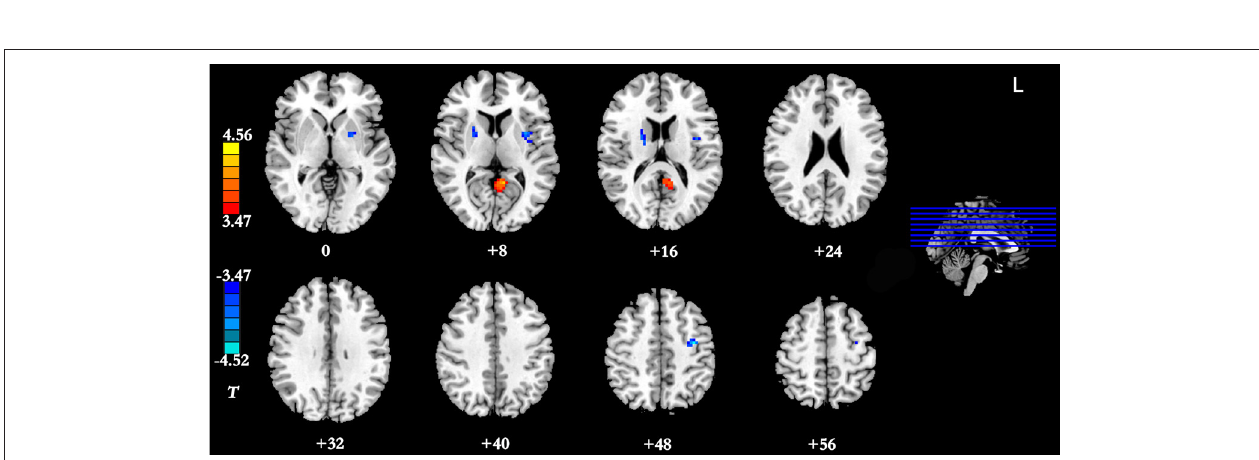
FIGURE 4 | Brain regions showing group differences between the IGD group and the HC group in dynamic FC with the right DLPFC as seed ROI ( p < 0.05, AlphaSim-corrected). Color bar, yellow (orange): regions showing significantly increased dynamic FC-variance, blue: regions showing significantly decreased dynamic FC-variance. IGD, internet gaming disorder; HC, healthy control; DLPFC, dorsolateral prefrontal cortex; FC, functional